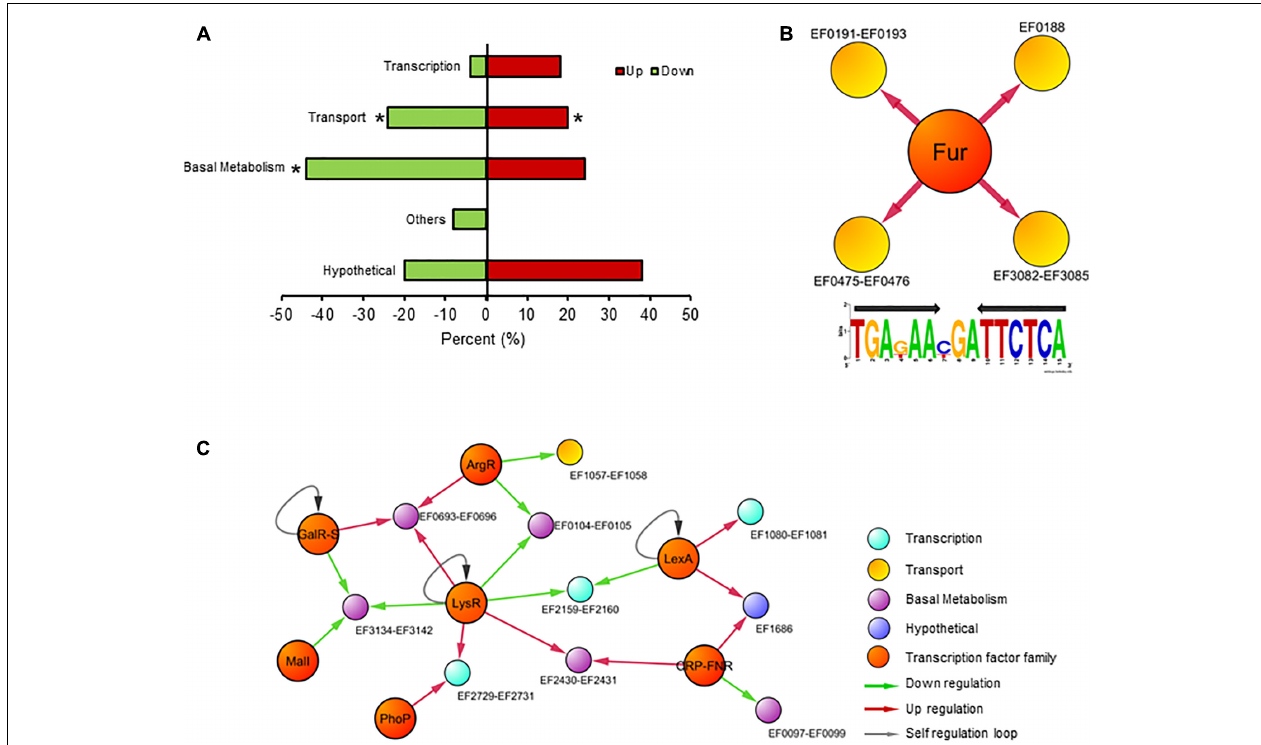
FIGURE 3 | Transcriptional response in the absence of Fur. (A) Global transcriptional analysis of E. faecalis wild type and (cid:49) fur growing in the iron control condition. RNAseq differentially expressed genes classify by COG super-class categories. Color bars represent the upregulated or downregulated genes in (cid:49) fur compared to the wild type. Asterisk denotes significant enrichment in the bacterial genome ( p (0.05) compared to total proportion. (B) Fur regulon of E. faecalis . Consensus logo of Fur regulon created with Fur DNA sequence found in promoters of EF0188, EF0191–EF0193, EF475–EF0476, and EF3082–EF3085 operons (the black arrow indicates palindromic sequence). (C) The graph contains 23 nodes (14 operons, 8 transcription factor families) connected by 26 edges (putative binding sites). Color circles represents COG super-class